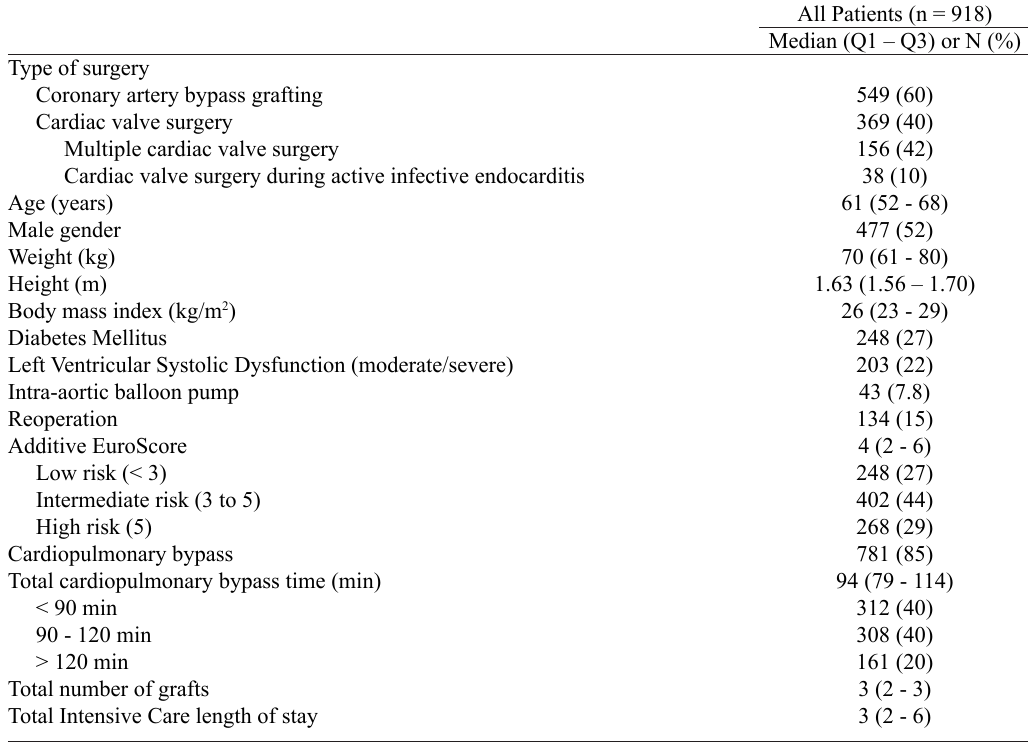
Table 2. Baseline characteristics of patients who underwent cardiac surgery.